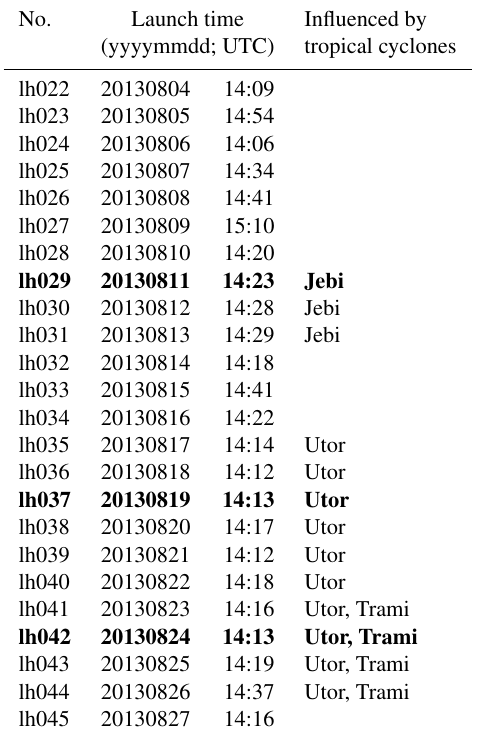
Table 1. Flight statics for balloon launches during the August 2013 SWOP campaign in Lhasa.